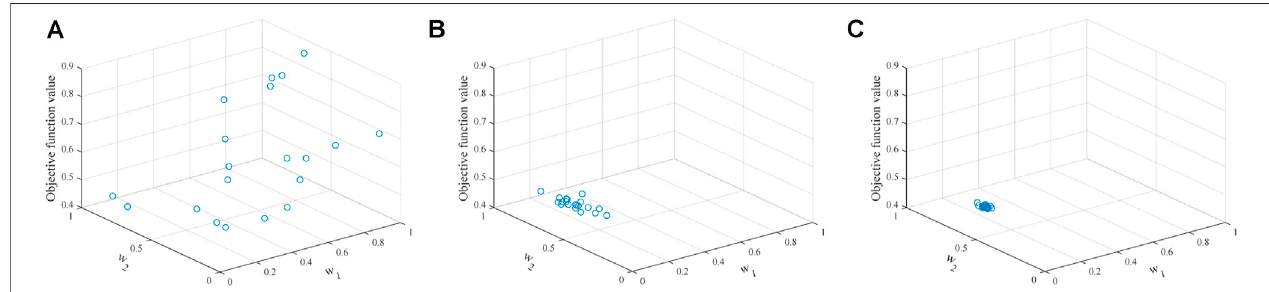
FIGURE 4 | Distribution of gray wolf population in the GWO optimization process. (A) Initial population. (B) The sixtieth generation population. (C) The ninetieth generation population.